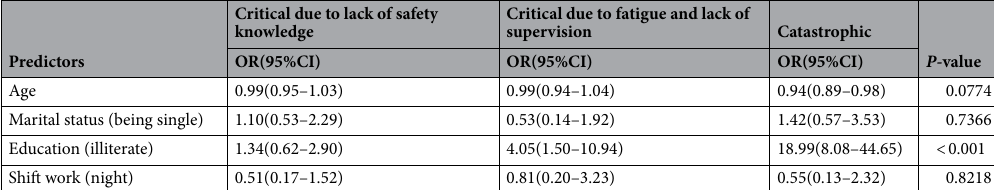
Table 4. Predictors of membership in latent classes of occupational accidents among industry workers.